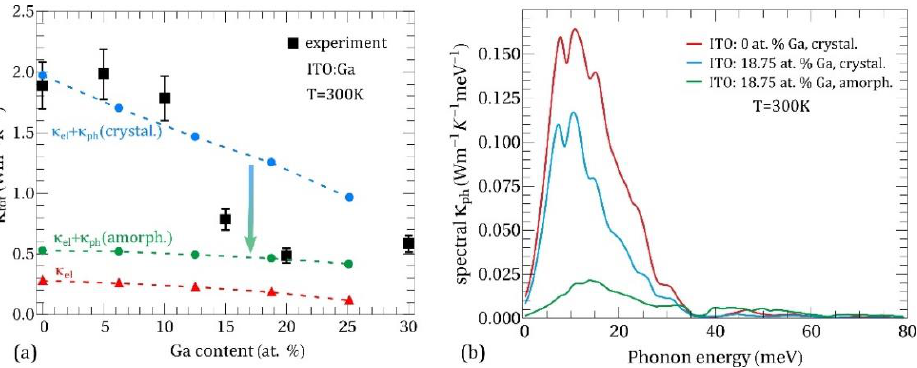
Figure 7. ( a ) Total thermal conductivity of ITO:Ga films at 300 K as a function of Ga content. Squares represent experimental data, while circles denote theoretical calculations with phonon lifetimes for crystalline (blue circles) and amorphous (green circles) materials. Electronic thermal conductivity is denoted by red triangles. ( b ) Spectral phonon thermal conductivity in ITO with 0 at. % Ga (red line) and 18.75 at. % Ga (blue and green lines) as a function of phonon energy. Calculations with “crystalline” and “amorphous” phonon lifetimes are presented.